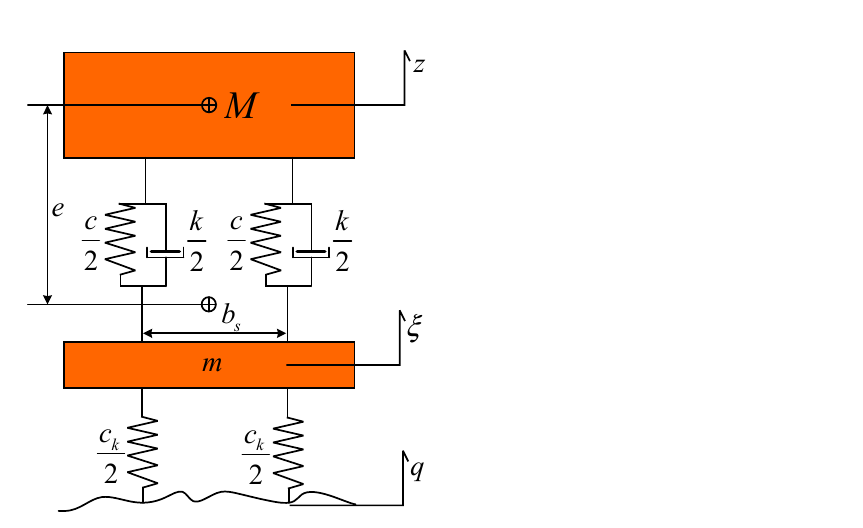
Figure 4. Schematic view of a passive vehicle suspension model.